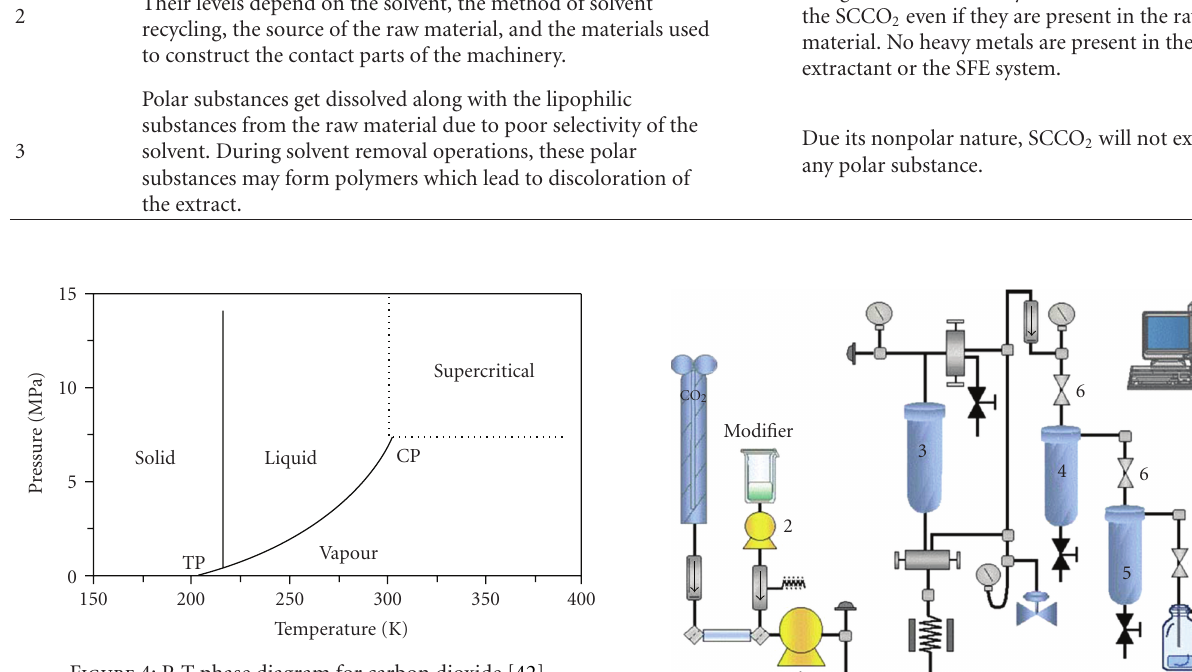
Figure 4: P-T phase diagram for carbon dioxide [42].